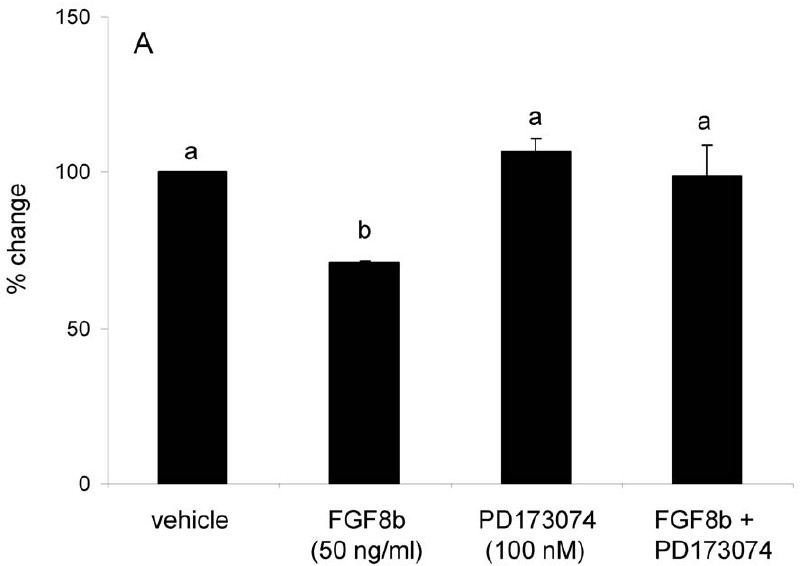
Figure 5. Effects of FGF8b on GnRH promoter activity. Transient transfection of GT1-7 cells with 0.15 m g/well of mouse full-length GnRH- luciferase reporter construct. Following transfection, cells were treated with vehicle, FGF8b (50 ng/ml), PD173074 (100 nM), or FGF8b + PD173074 for 8 hours. Data are represented as mean percent change in RLU’s from vehicle-treated controls 6 SEM. Dissimilar letters indicate statistically significant difference among groups, P , 0.05.